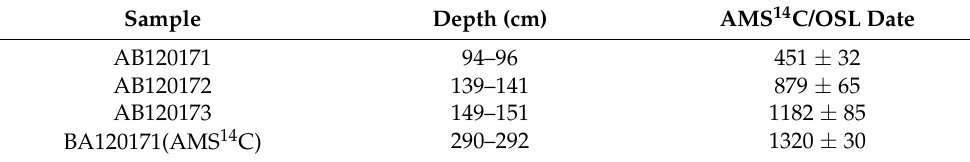
Table 2. AMS 14 C/OSL age data in the SZP profile (date from Tan’s publication) [29]. Sample Depth